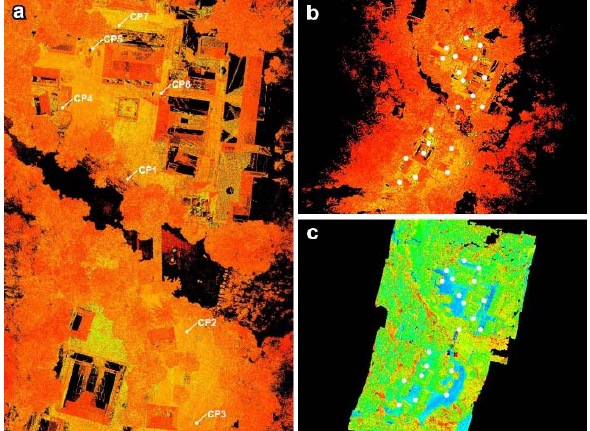
Figure 7. Three-dimensional modeling of the Magoksa Temple: (a) Seven ground control points; (b) Registration points of the terrestrial scanning; (c) Point clouds extracted from UAV photogrammetry result